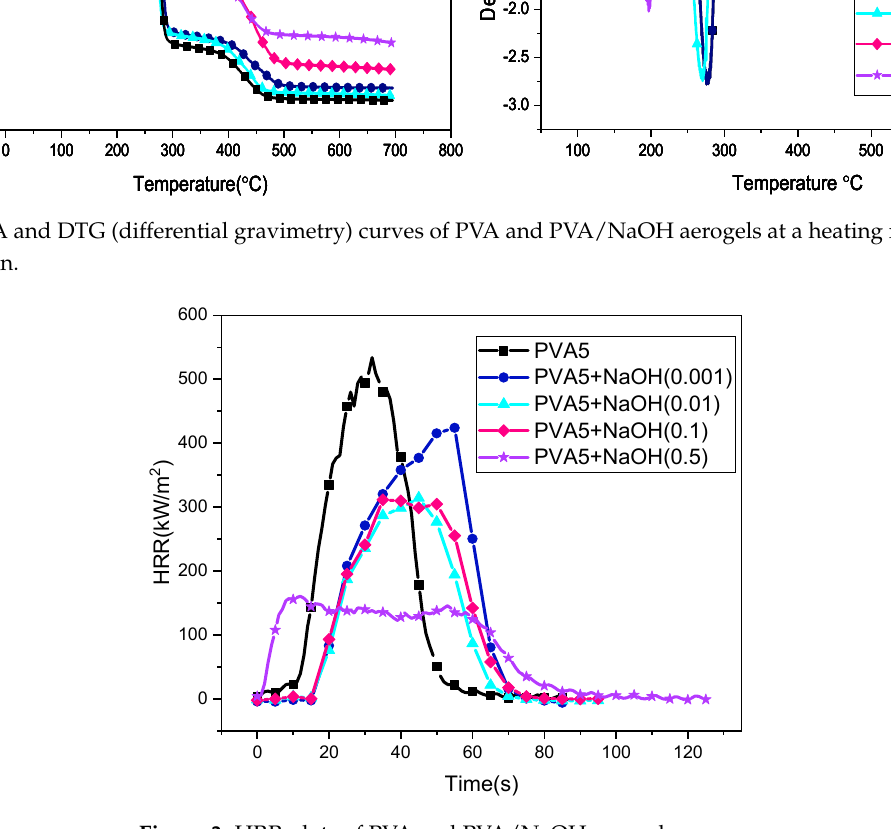
Figure 3. HRR plots of PVA and PVA/NaOH aerogels. Table 3. TGA (thermogravimetric analysis) data of freeze dried PVA and PVA/NaOH aerogels.